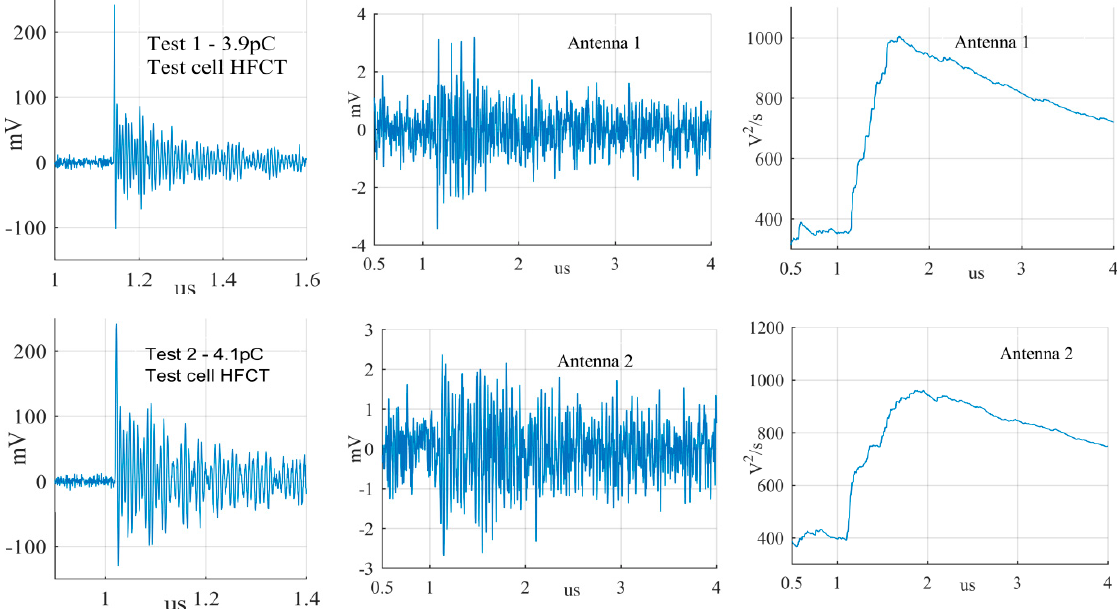
Figure 15. Smallest corona discharge from the antenna at position 1 and